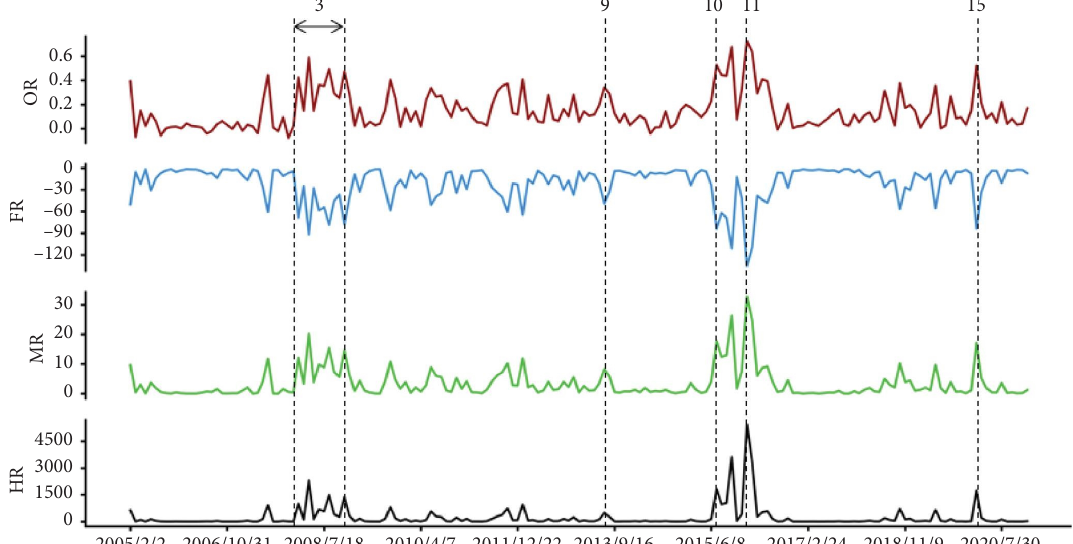
Figure 4: Type (i) curvature time